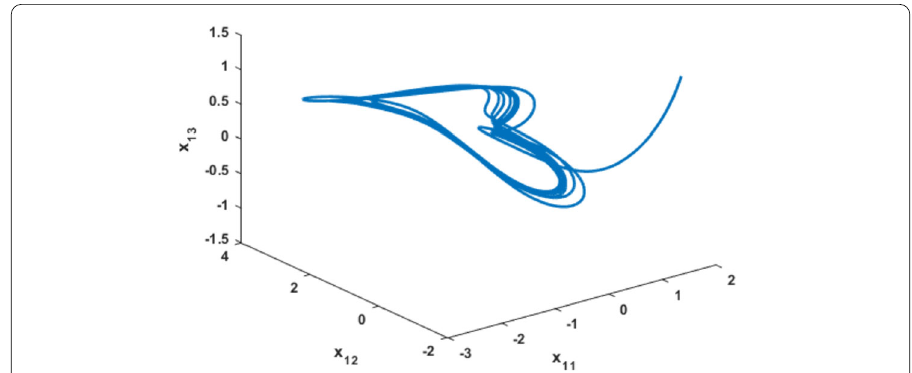
Figure 5 The chaos attractor of system (59) with x 11 (0) = 2, x 12 (0) = –3, x 13 (0) = 2